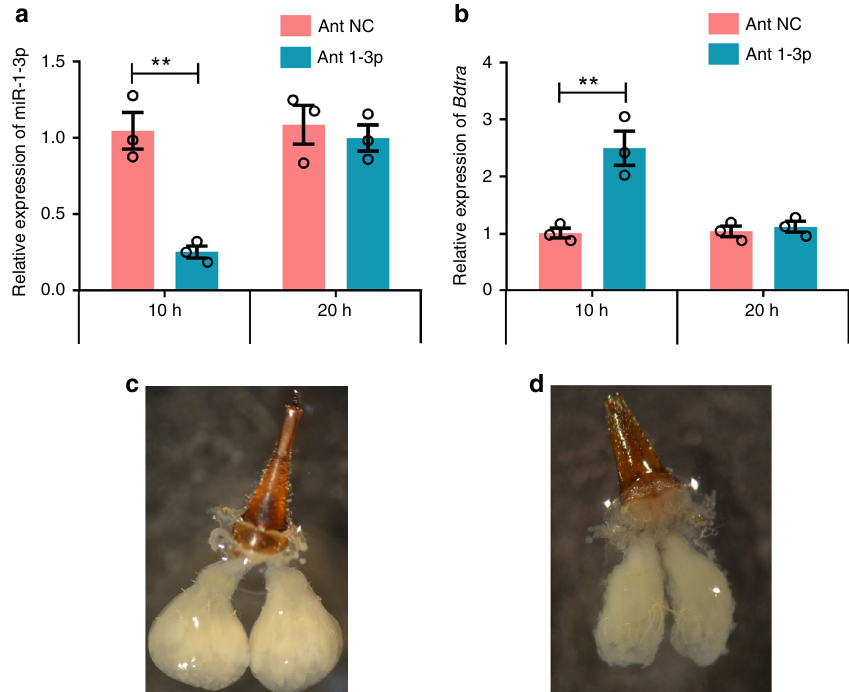
Fig. 6 Embryonic silencing of miR-1-3p leads to incomplete feminization. a Relative expression levels of miR-1-3p transcript in embryos 10 h and 20 h after injection of the miR-1-3p antagomir, ( b ) relative expression levels of Bdtra transcript in embryos 10 h and 20 h after injection of the miR-1-3p antagomir, ( c ) dissected normal ovaries from a female injected with the antagomir negtive control (NC), and ( d ) dissected partially feminized ovaries from a female injected with the miR-1-3p antagomir. Error bars indicate the SEM of three independent biological replicates and asterisks (**) indicate the statistically signi fi cant differences ( P < 0.01) between the treatment group and control group based on Student ’ s t